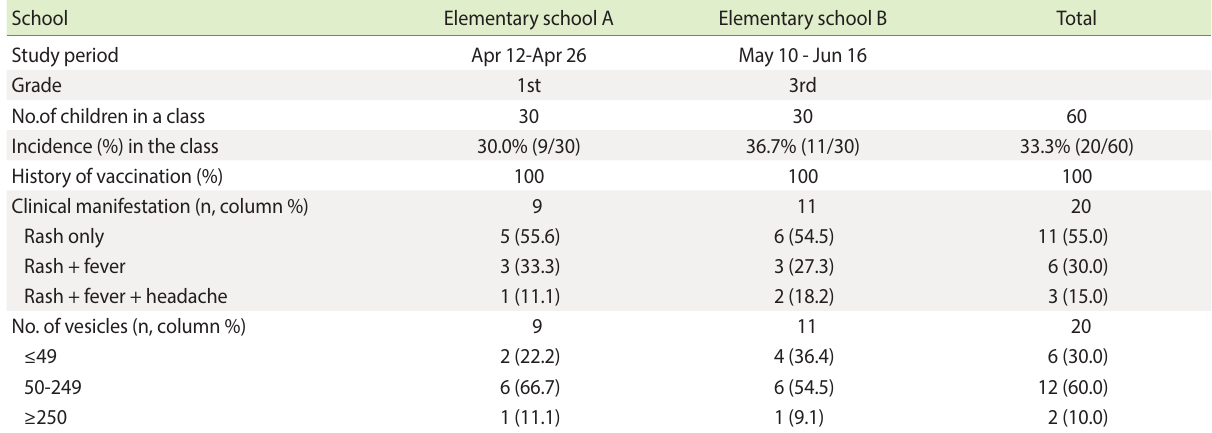
Table 1. Summary of two epidemiologic investigations carried out in Jeju-si, Korea in the first half of 2017